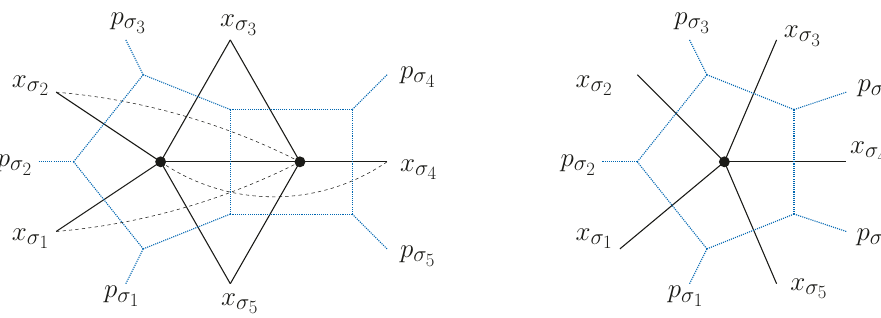
Figure 2 . The two-loop pentabox topology (l.h.s.) and the one-loop pentagon topology (r.h.s.) in momentum space (drawn by blue dotted lines) and their dual momentum representation (solid black lines). Integration vertices of the dual graph are denoted by black blobs. Dashed black lines denote numerators. Labels σ of the external momenta and the dual momenta are cyclically 1 , σ 2 , . . . , σ 5 ordered, such that x = p σ i − x σ i − 1 σ i